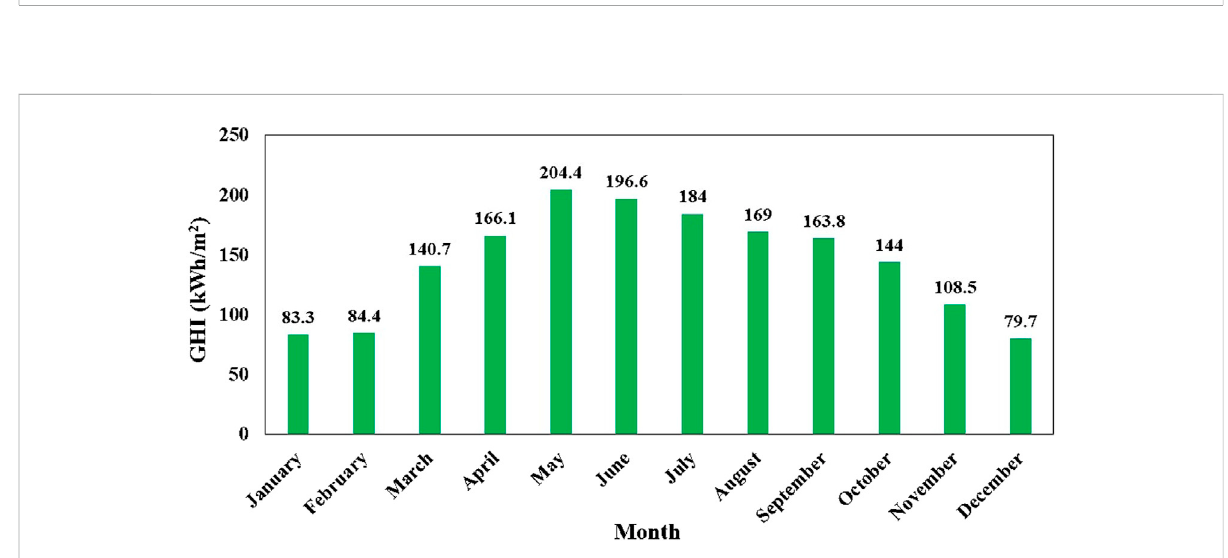
FIGURE 6 Annual global horizontal irradiance